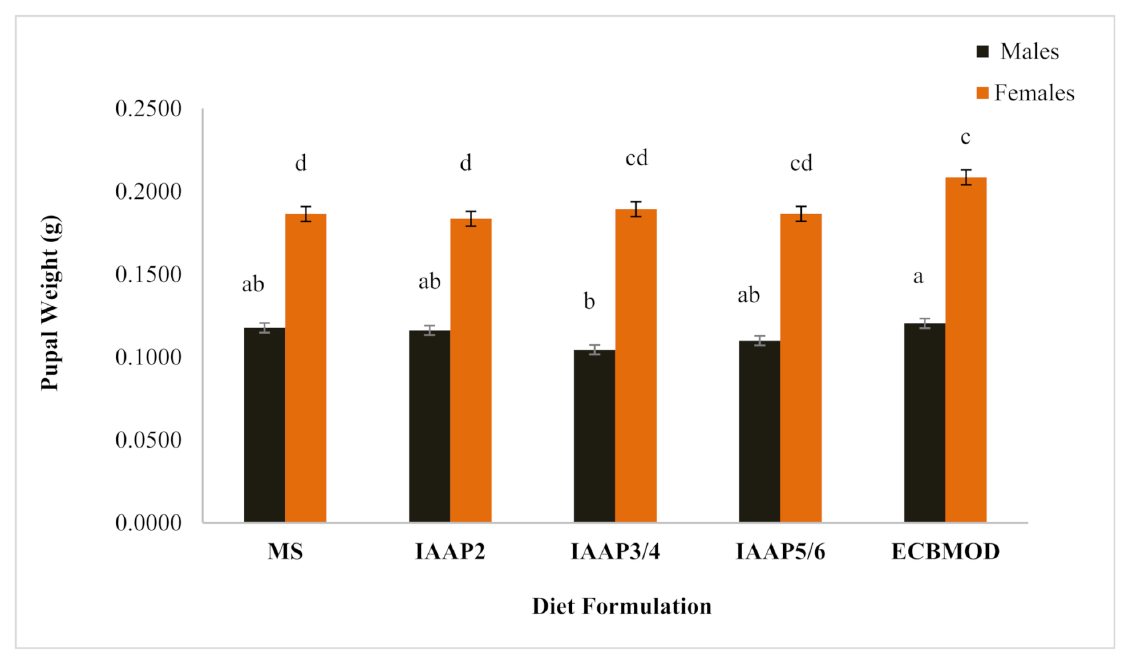
Figure 1. Mean ( ± SE) Eldana saccharina male and female pupal weights ( n = 30) at harvest (day 27) from the minimum specifications (MS), ideal amino acid profile of second instar E. saccharina larvae (IAAP2), ideal amino acid profile of third and fourth instar larvae (IAAP3/4), ideal amino acid profile of fifth and sixth instar larvae (IAAP5/6) and control (ECBMOD) diets. Different lower-case letters above the graph histogram bars indicate that mean differences are significant at the 0.05 level.